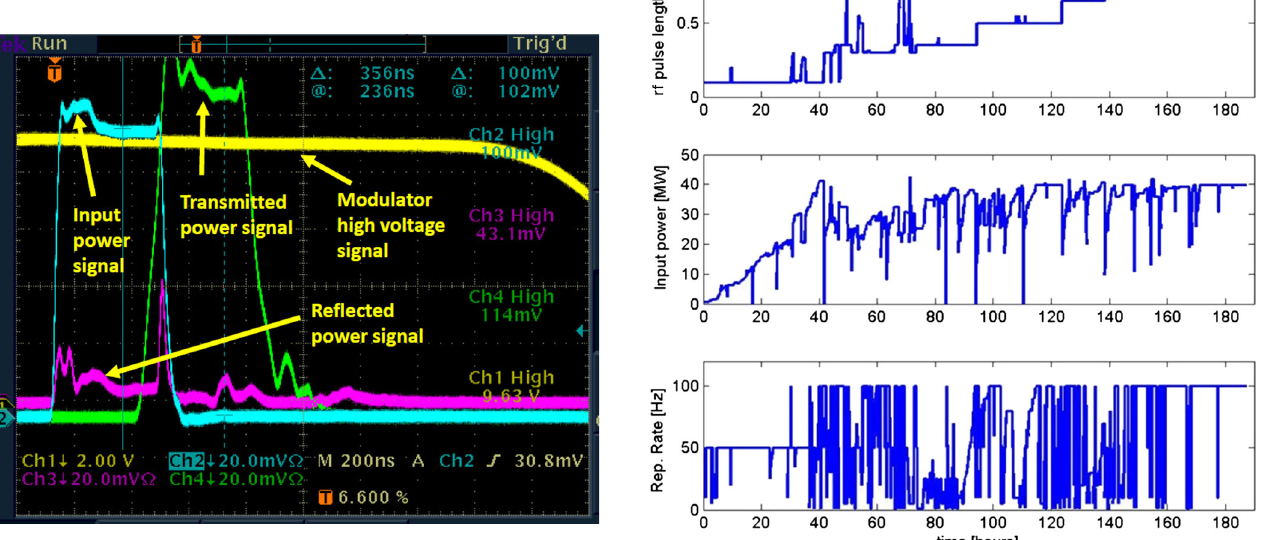
FIG. 17. Behavior of the rf pulse length, input power, and repetition rate as a function of time during the high power test of the C -band